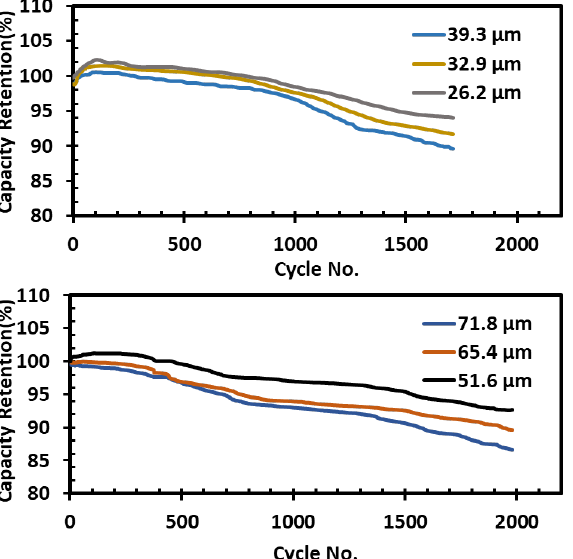
Figure 9. Long-term cycle performance of cell with different electrode thicknesses. The internal resistance of the cell was measured every 500 cycles. As shown in Figure 10, the internal resistance of the cell is a function of the cycle number. The internal re- sistance of the cell with difference electrode thicknesses displayed a similar trend, increas- ing with the number of cycles.